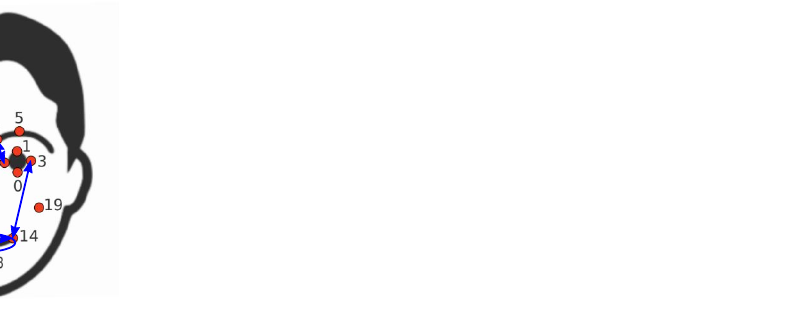
Figure 6. Selected points of interest (POI) (red) and distances (blue) for computation of indicators. Table 7. Overview of the meanings of the indicators. The position of index p is shown in Figure